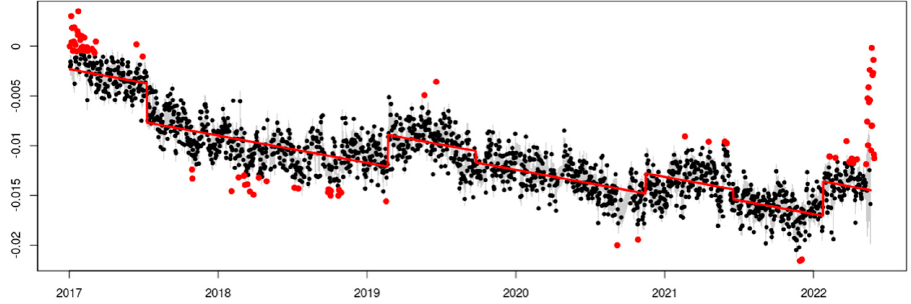
Figure 7. The eliminating outliers and definition of offsets in the time series of the EPEC station. The outliers are in the color red and were not taken into account in the next steps. The offsets are presented in seven sections through the time series.